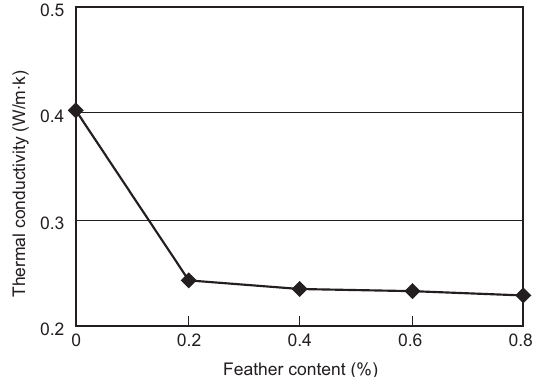
Figure 7 Typical fracture face of hardened mortar cubes with admixed